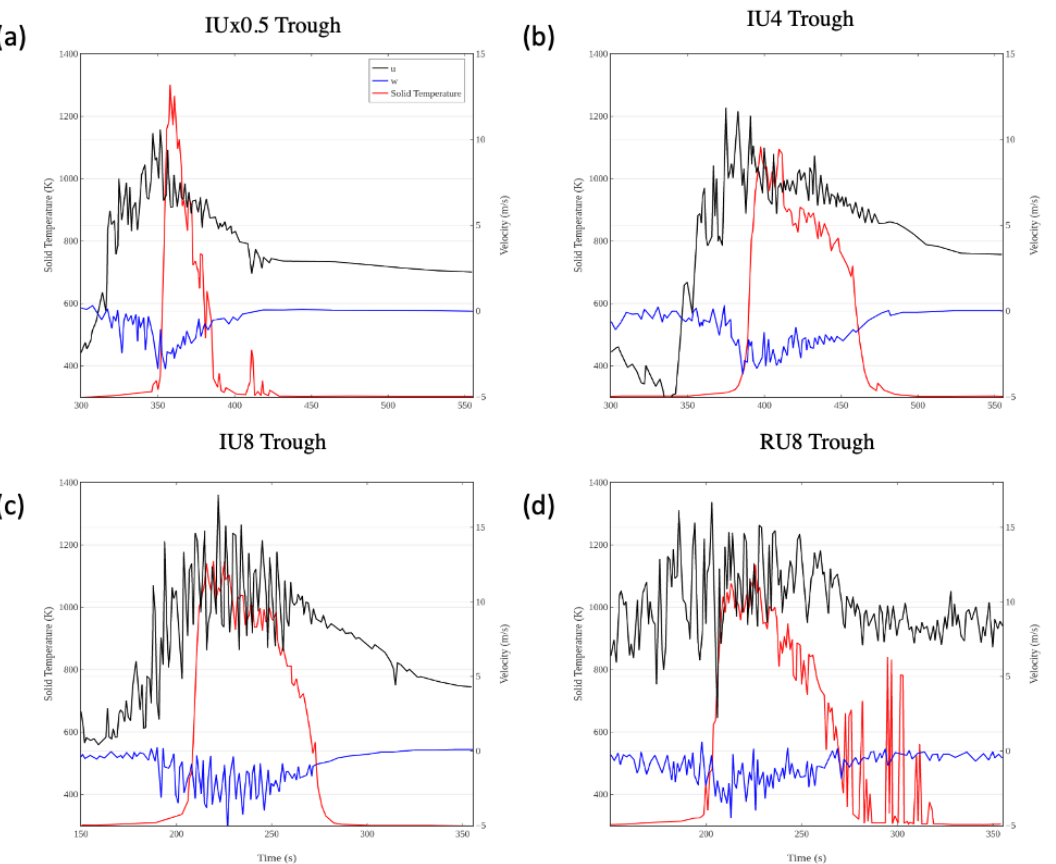
Figure 8. Non-stationary trough plots of solid temperature (red lines), horizontal wind velocity (black lines) and vertical wind velocity components (blue lines). Panel titles indicate the simulation cases being depicted. ( a ) IUx0.5 Trough ( b ) IU4 Trough ( c ) IU8 Trough ( d ) RU8